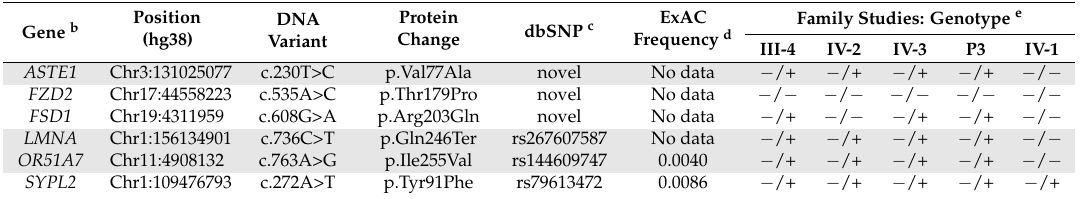
Table 1. Family studies of the high-priority variants to identify genetic factors in DD and LD a . Position Gene b